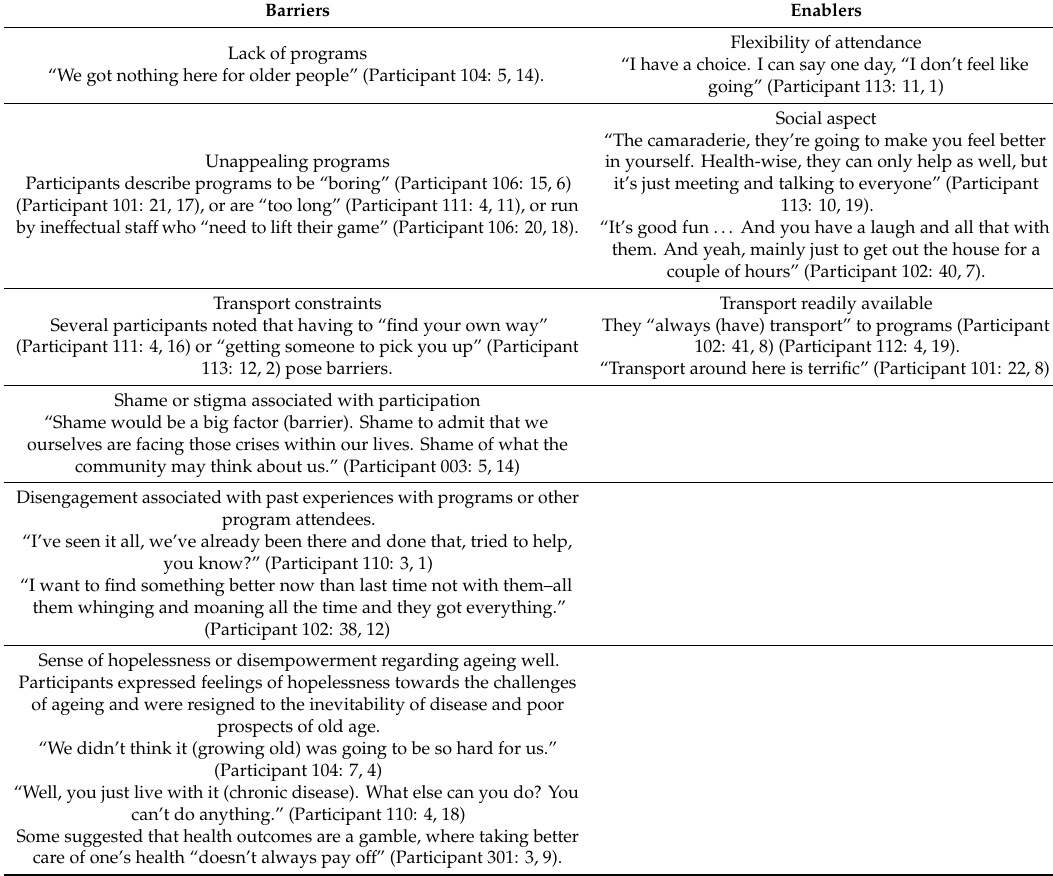
Table 1. Barriers and enablers of participation in current community health programs. Barriers Enablers Lack of programs “We got nothing here for older people” (Participant 104: 5,